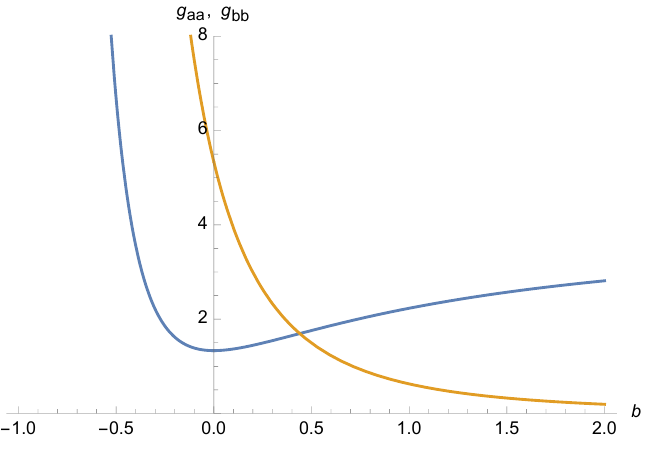
Figure 2 . Moduli space metric components in Q φ = ± 1 BPS sector: g aa (blue) and g bb